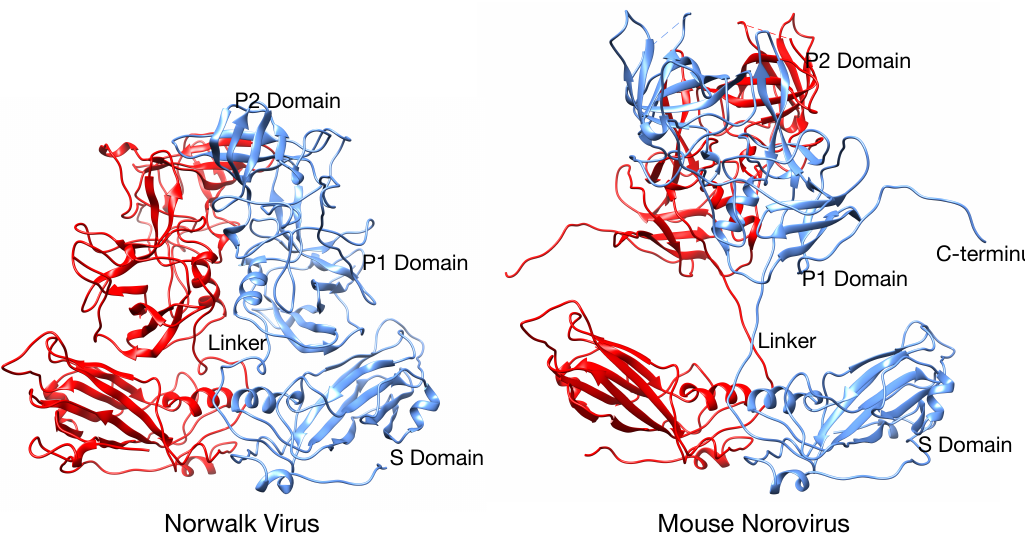
Figure 3. Comparison between the compressed and expanded states. Shown in this figure is the crystallographic structure of NV [11] and the pseudo atomic model of MNV based on the cryo-EM structure [14,19,20] to demonstrate the extreme movement in the P domain off the shell surface in MNV. The A and B subunits are colored red and blue to show the dimer